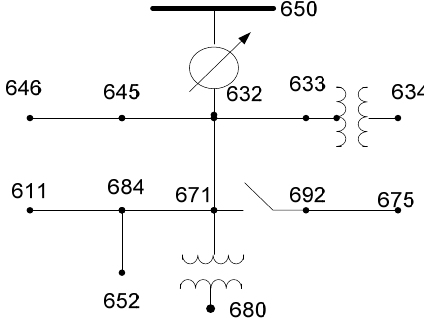
Figure 4. Schematic diagram of the proposed system.